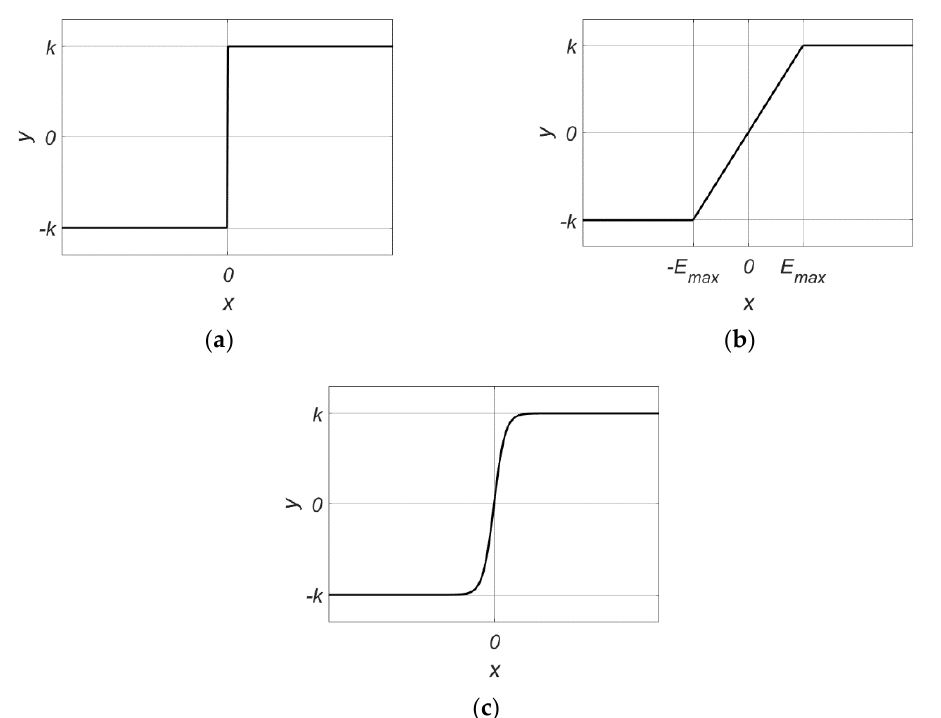
Figure 7. Possible switching function that can be used in the SMO algorithm: ( a ) signum function; ( b ) saturation function; ( c ) sigmoid function.